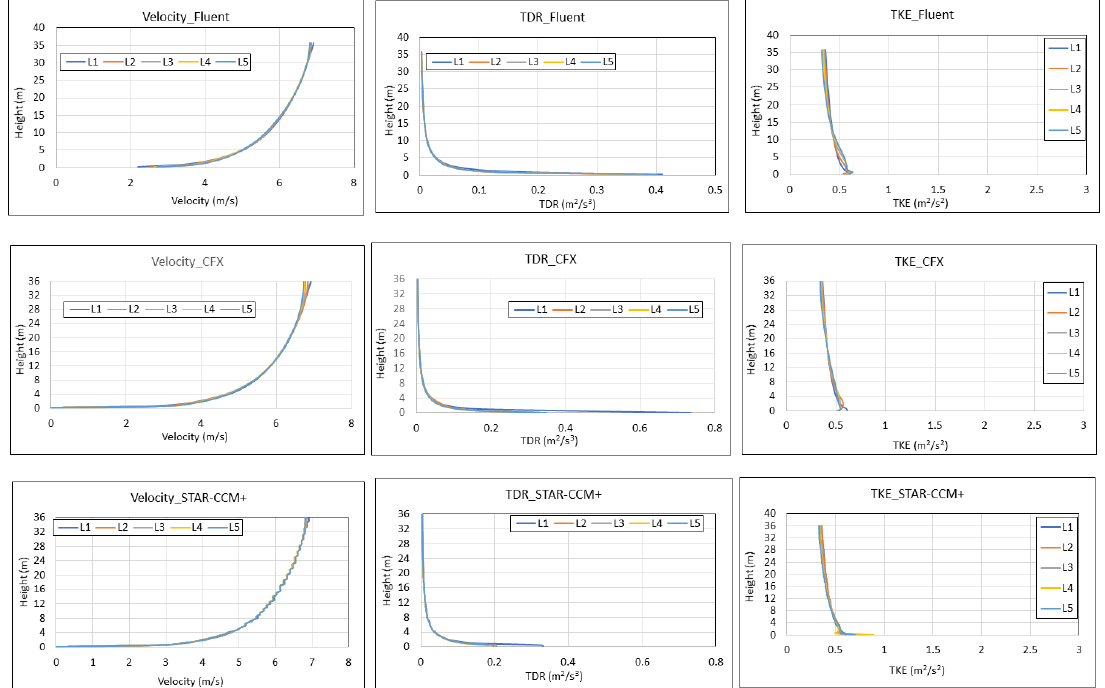
Figure 11. Case 2: Comparison of the vertical profiles at the 5 different locations for the streamwise velocity ( u ), TKE, ( k ), and turbulent dissipation rate, TDR, ( ε ) for each software.